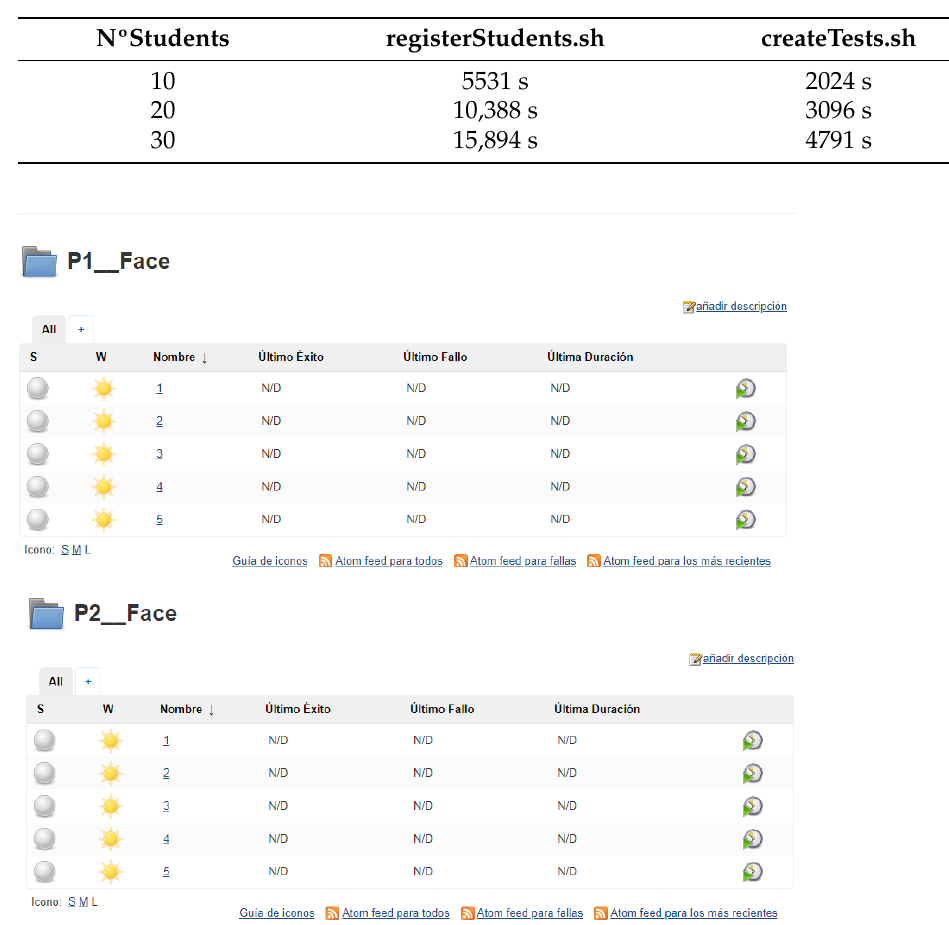
Table 3. Configuration times of Jenkins for each script.